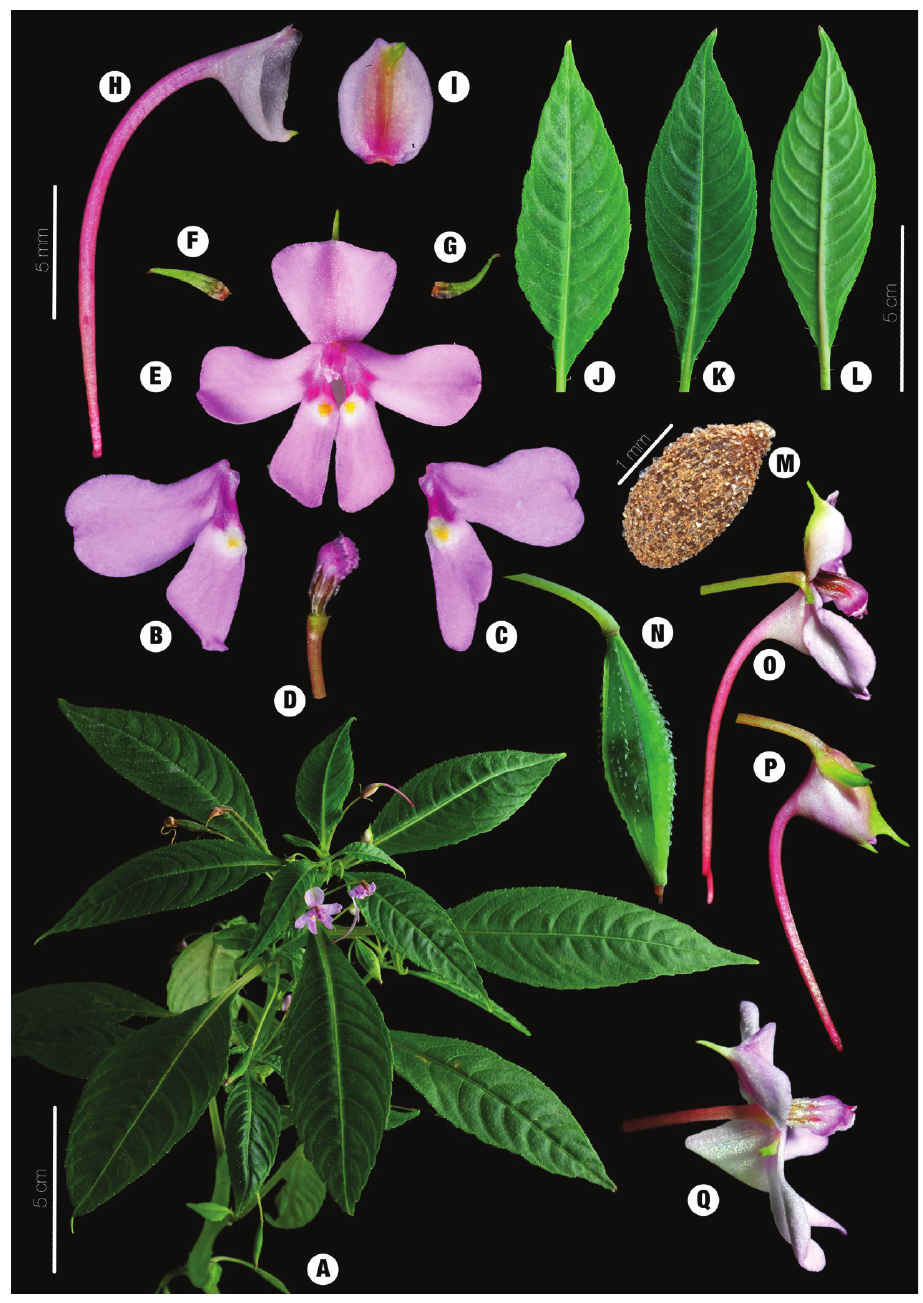
Figure 3. Impatiens chenmoui sp. nov. A habit B, C united lateral petals D ovary surrounded by stamens E flower front view F, G lateral sepals H spur I dorsal petal J–L leaves M seed N capsule O, P long-spurred flower side view Q non-spurred flower side